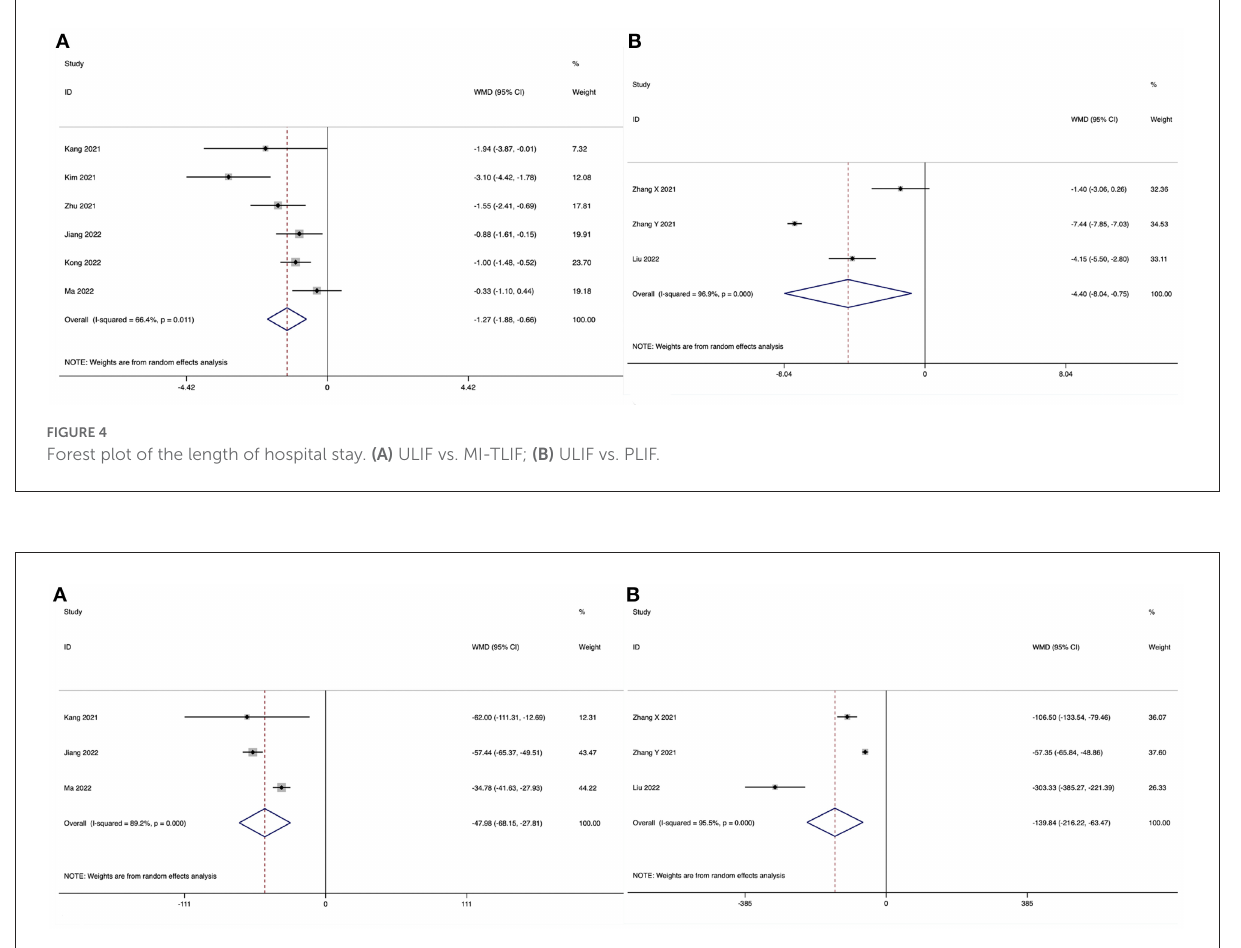
FIGURE5 Forest plot of the post-operative drainage. (A) ULIF vs. MI-TLIF; (B) ULIF vs.